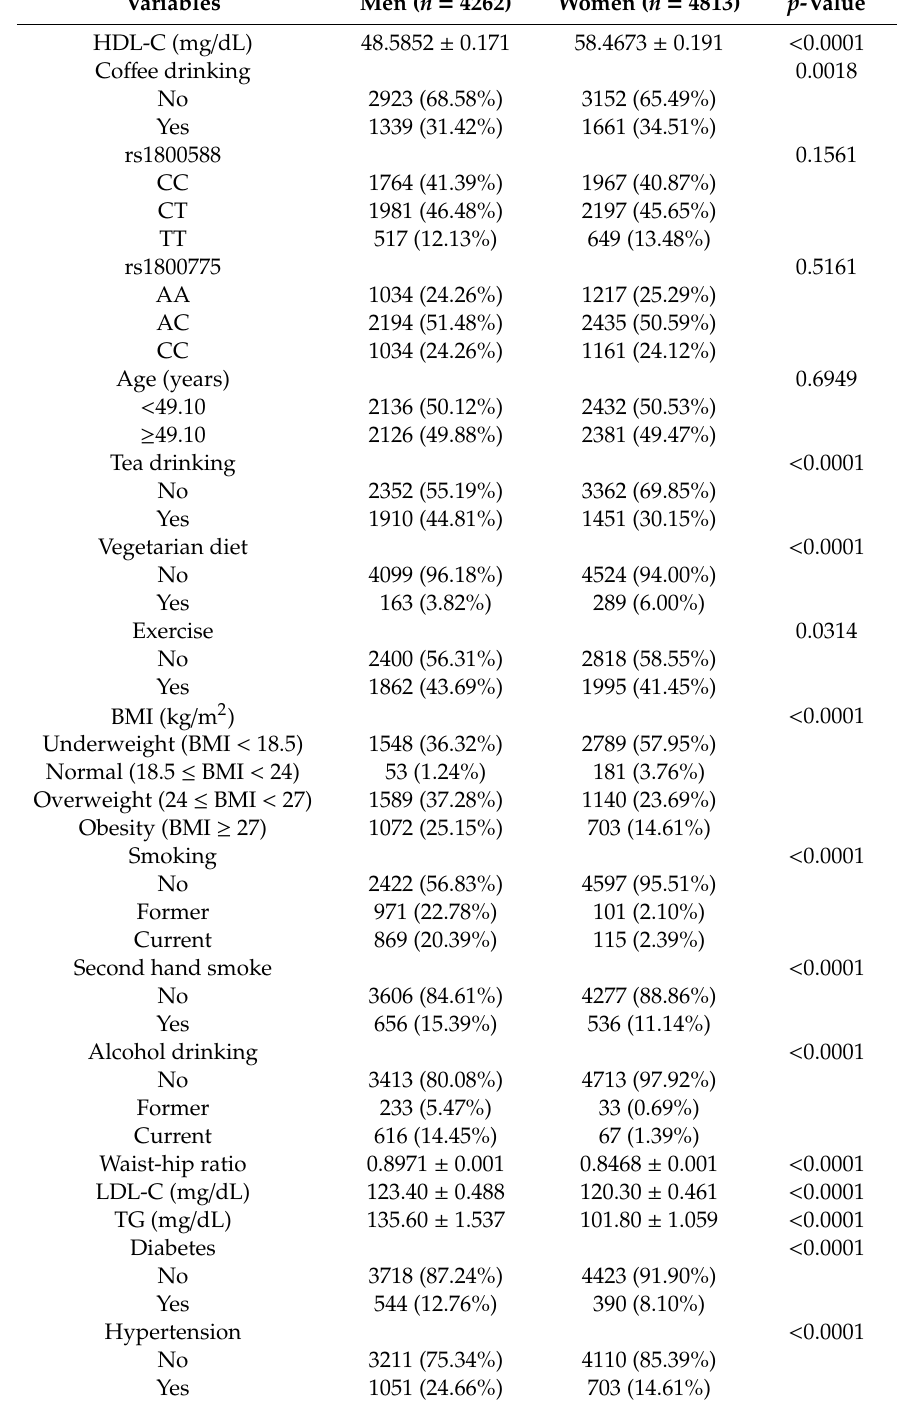
Table 1. Basic characteristics of male and female